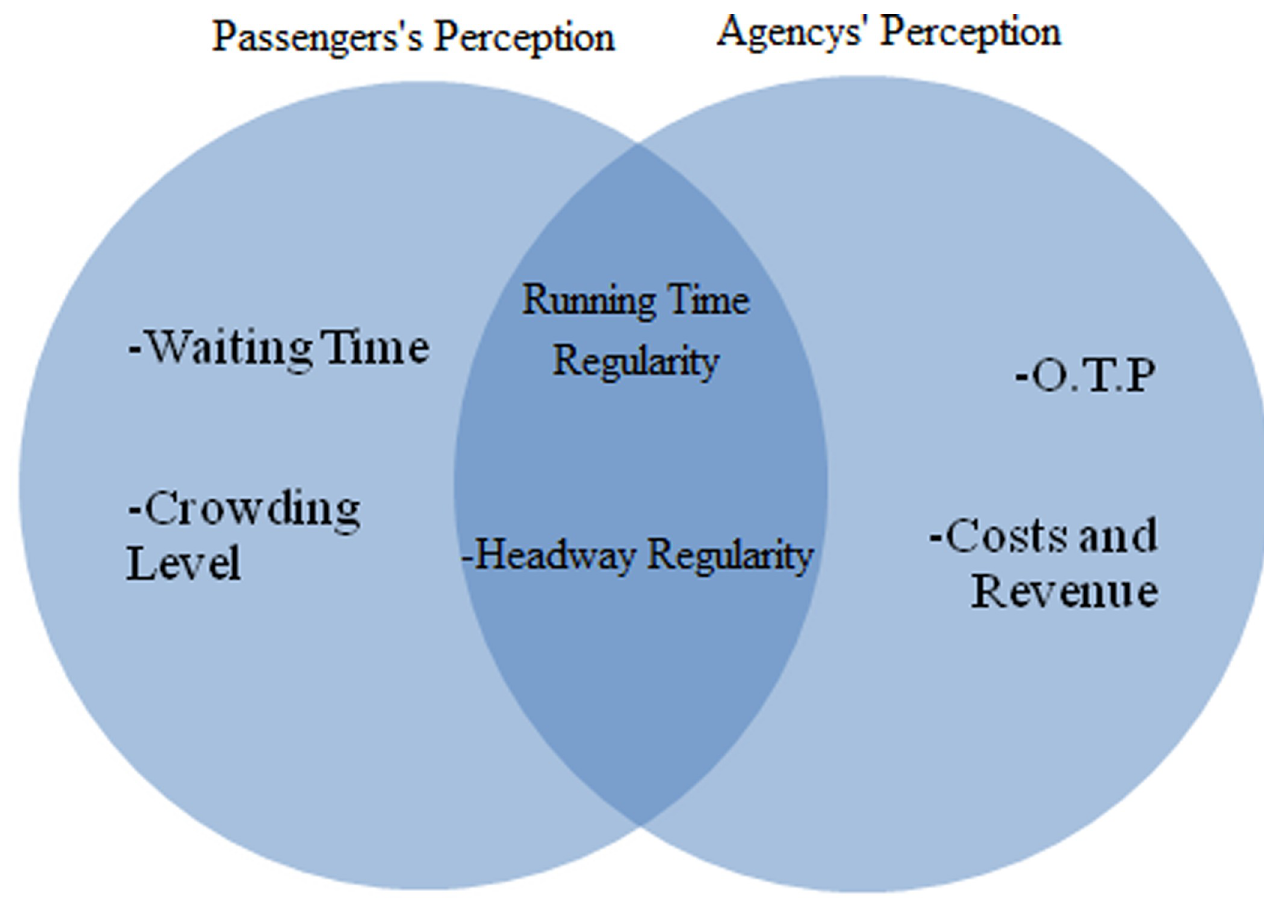
Fig 1. Reliability definition from passengers’ and agencies’ point of